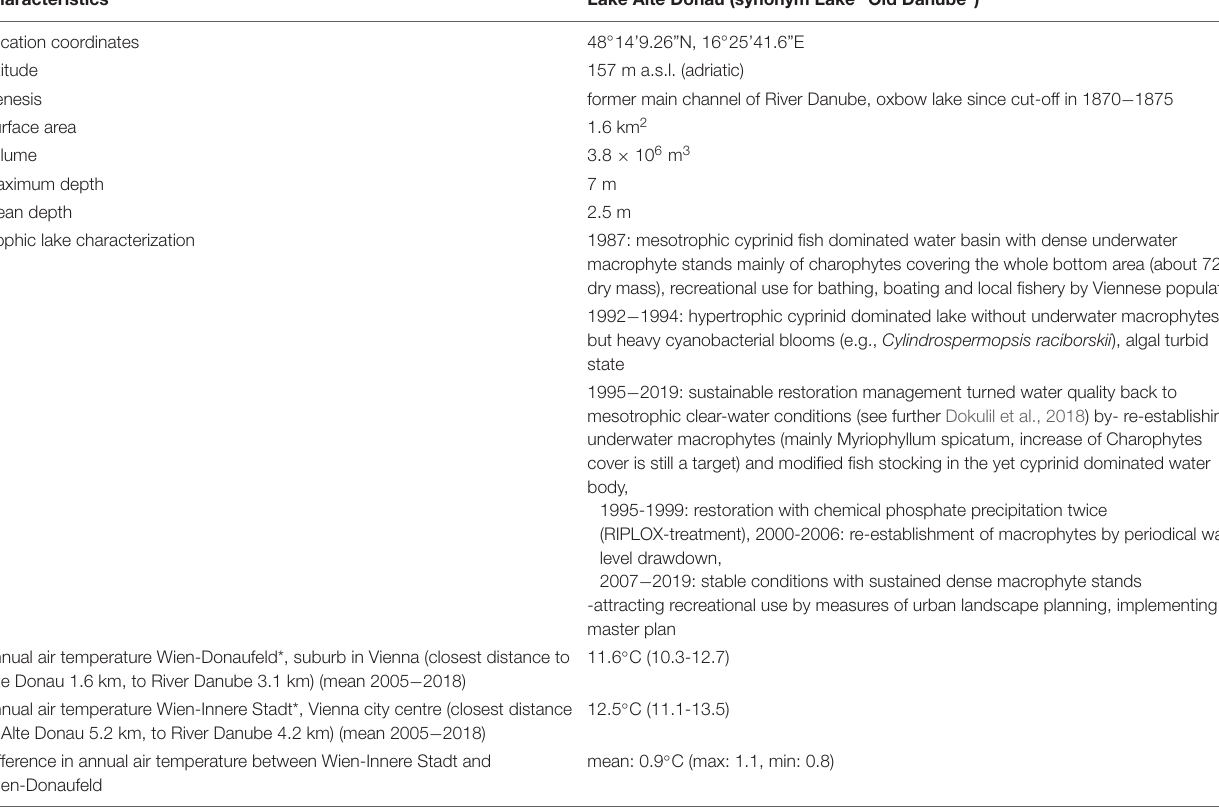
TABLE 1 | Main characteristics of oxbow lake Alte Donau in